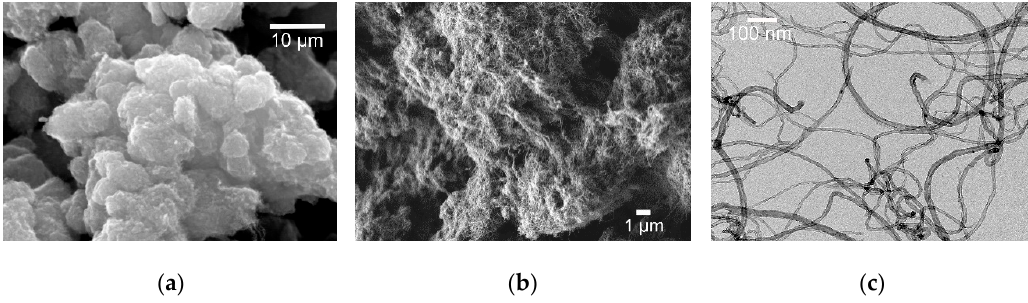
Figure 1. Configuration of the MWCNT “CNT-K” (Future Carbon GmbH, Germany) at different scales. From left: ( a ) CNT-K agglomerate at macro scale (SEM, 2020×, Marco Breidinger); ( b ) surface of CNT-K agglomerates (SEM; 5000×, Katia Rodewald); ( c ) single CNT-K network at nano scale (TEM, 50,000×, Dr. Sebastian Schwaminger)